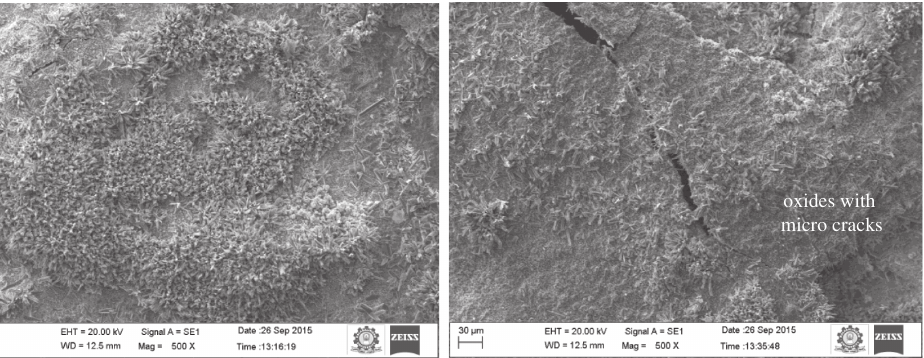
Figure 8: SEM micrograph indicating the oxides in the form of whiskers and micro cracks on the surface of the exposed samples.